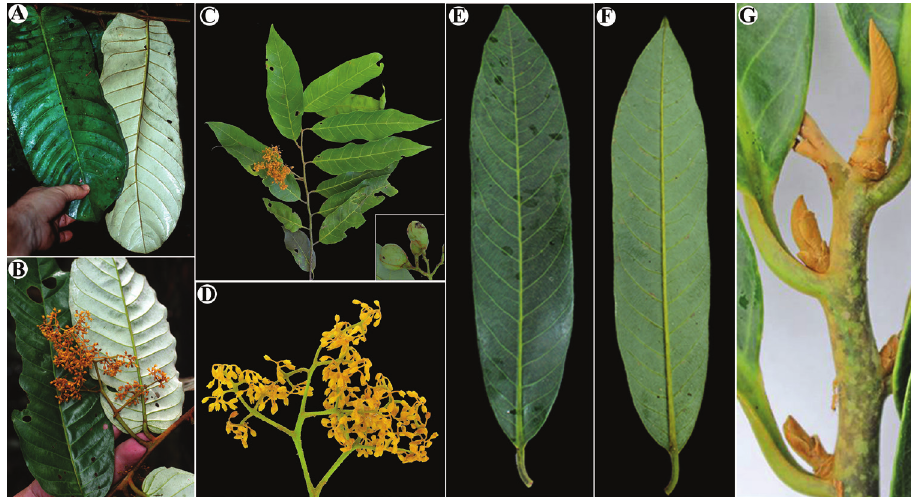
Figure 10. Virola calophylla A branch with leaves, showing both sides B branch with inflorescences. Vi- rola elongata C leafy branch with inflorescences, inset fruit D inflorescences. Virola guatemalensis E, F leaf blades showing adaxial ( E ) and abaxial ( F ) surface. G young twigs and petioles. Photos by Robin Foster ( A, B ) , from https://plantidtools.fieldmuseum.org/en/nlp; Steven Paton ( C, D ) , Rolando Pérez ( C inset), from https://stricollections.org/portal/index.php and Angela Rojas ( E–G